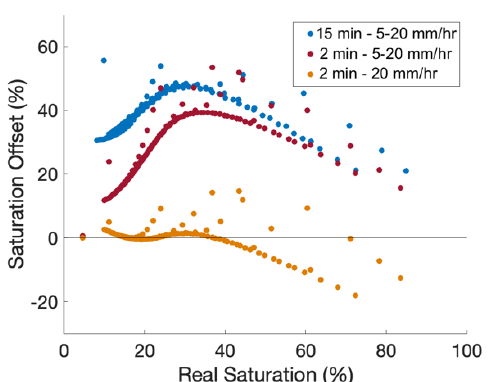
Figure 5. Comparison of three calibration curves: a 15 min heat pulses with recharge rates of 5 to 30 mm/hr, a 2 min heat pulses with 5 to 30 mm/hr of recharge, and a 2 min heat pulses with 20 mm/hr recharge. The first and second calibrations incorporate a range of recharge values (i.e., 5 to 30 mm/hr) in the training set, while the third uses only the 20m mm/hr recharge data. All three calibrations methods are tested using a full range of recharge scenarios from 5 to 30 mm/hr. Real Saturation refers to measurements at the observation node.